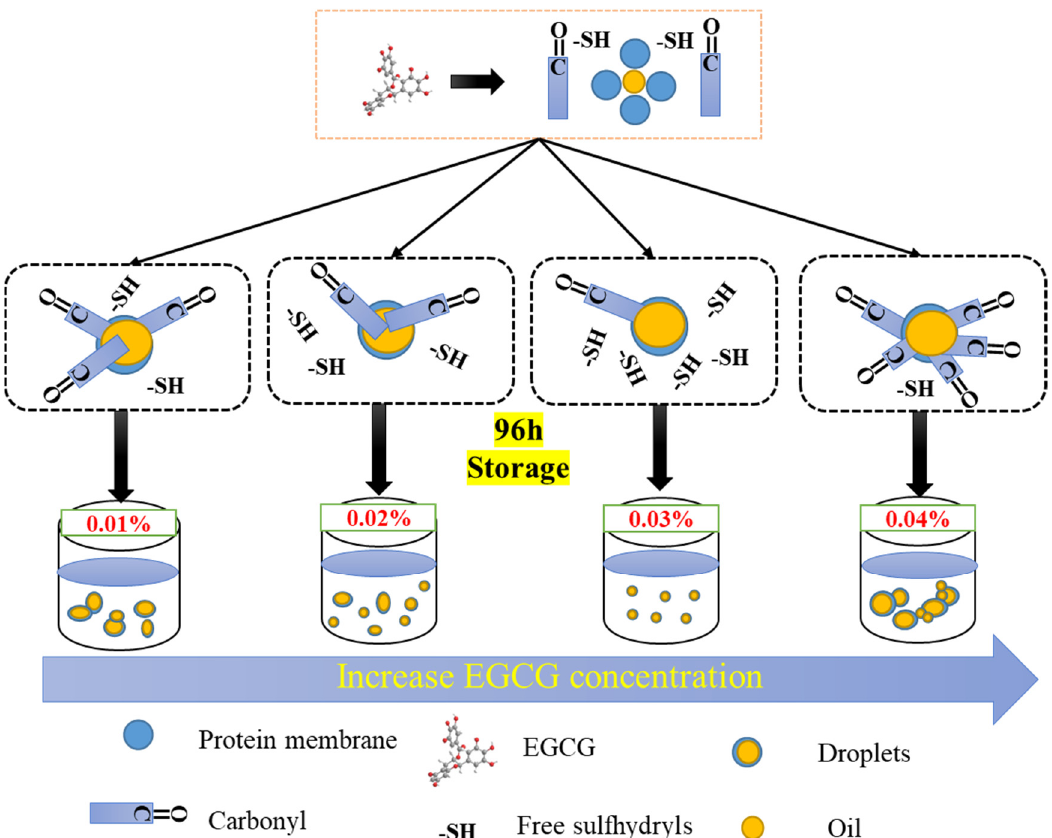
Figure 7. Schematic diagram of the effect of EGCG with different contents on WBMP emulsion.